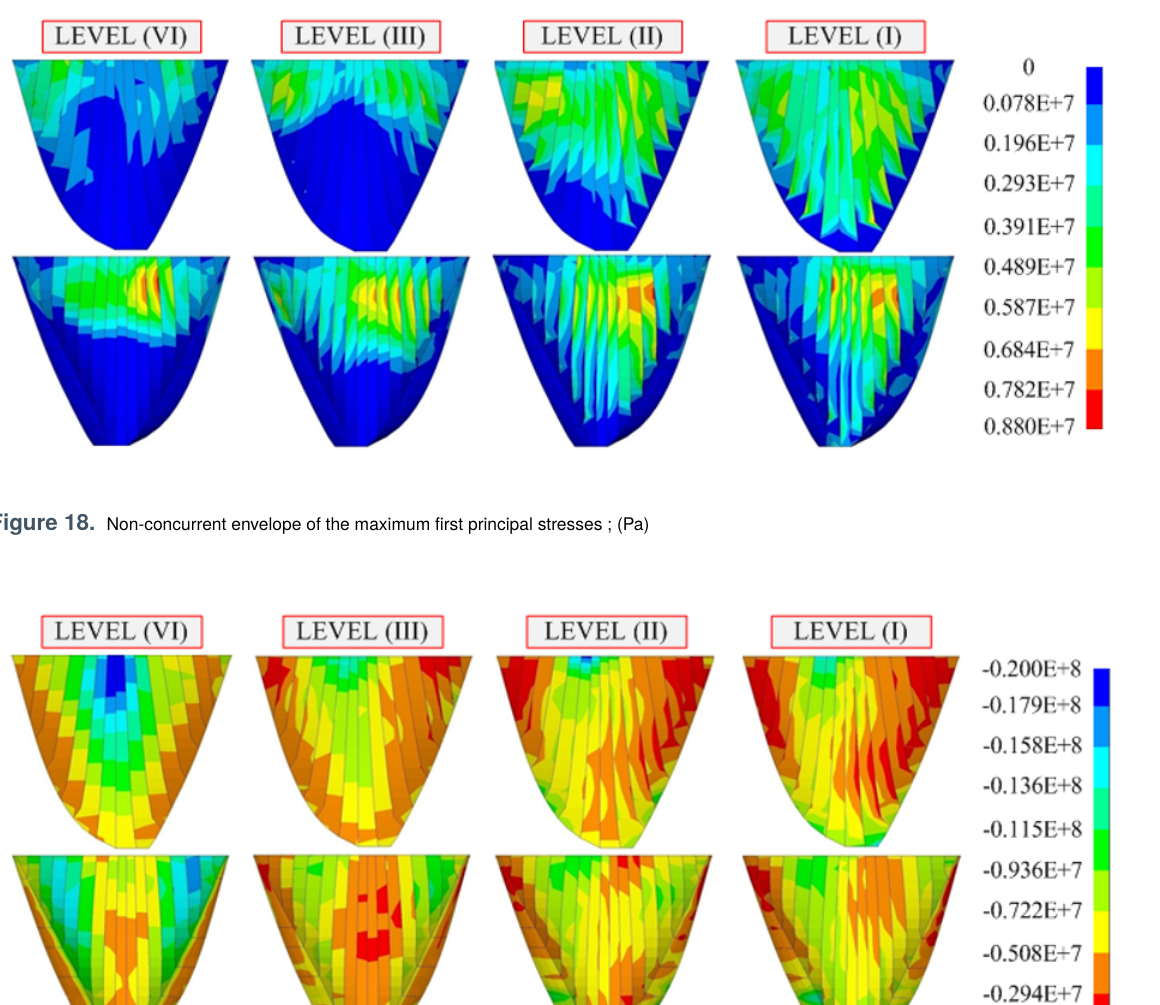
stress) is larger for NL-DCM. This fact shows that the presence of joints has a significant effect on the behavior of the dam body. In addition, comparing nodal stresses using uni-axial and biaxial stress criterion, the trend of changing the number of cracked nodes with fluctuating the reservoir water level are the same. However, the number of node candidates for cracking in NL-DCM is somewhat less than those in LE